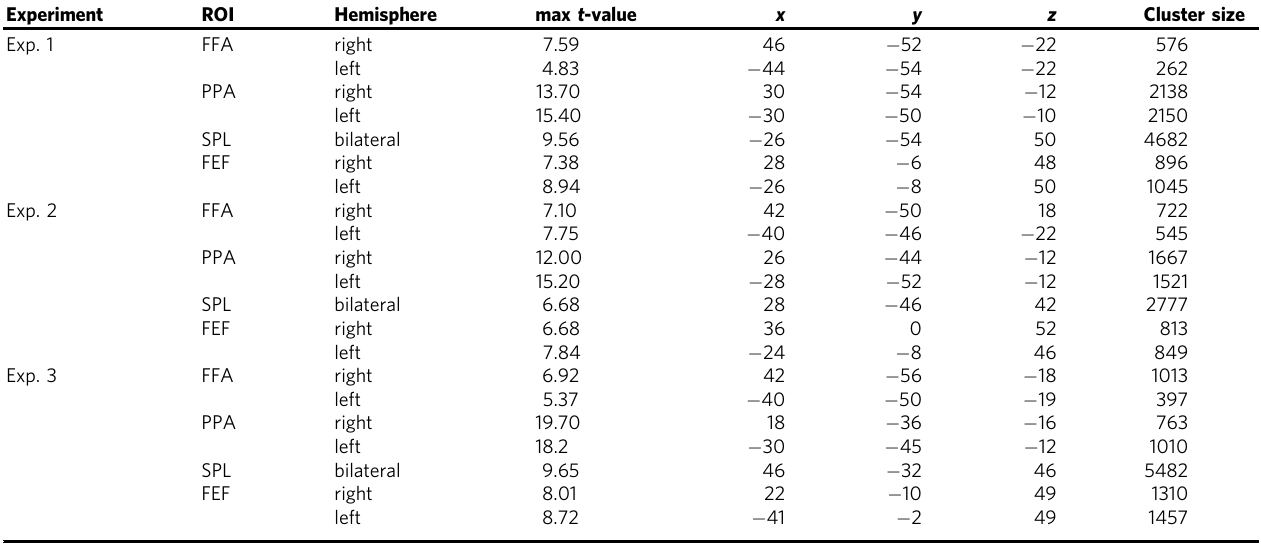
Table 1 List of regions of interest in 2 mm MNI standard space.